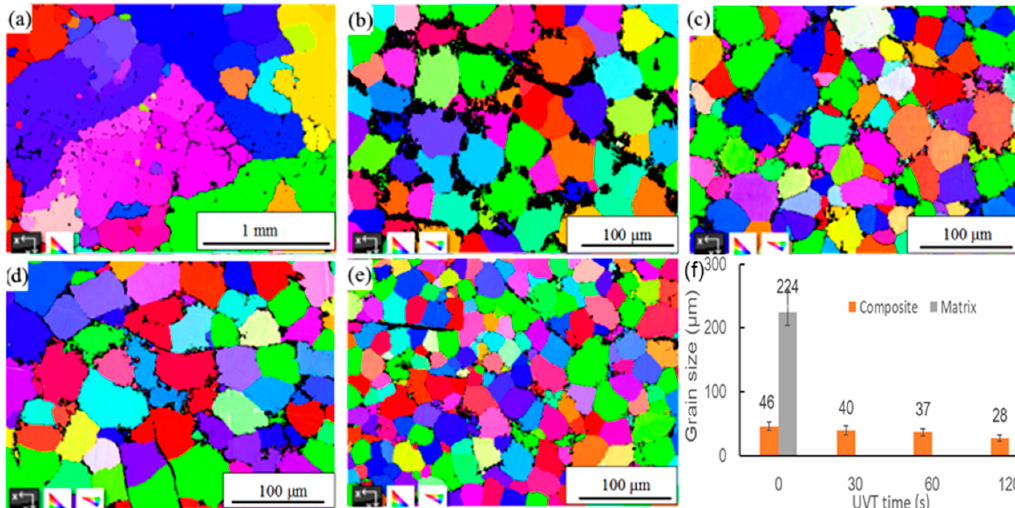
Figure 5. Electron backscattered diffraction (EBSD) (IPF X) images of TiB 2 /2A14 composites with UVT. ( a ) 2A14 matrix alloy, ( b ) UVT for 0 s, ( c ) UVT for 30 s, ( d ) UVT for 60 s and ( e ) UVT for 120 s; ( f ) is the average grain size of the TiB 2 /2A14 composites.